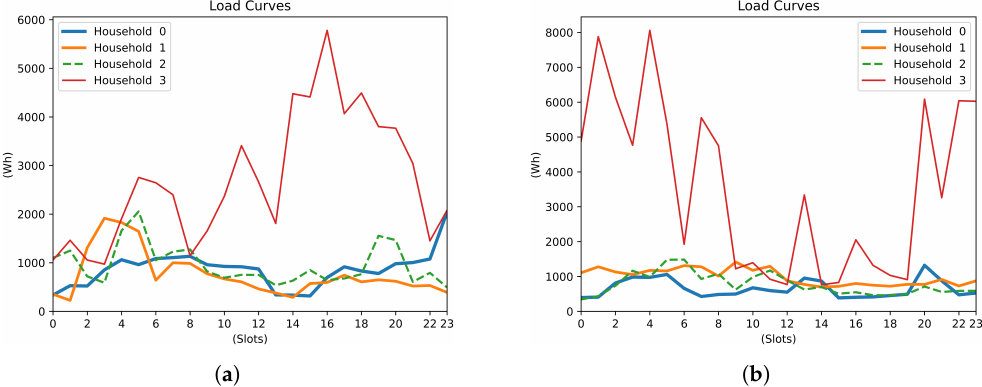
Figure 5. Load curves for two days in different seasons. ( a ) Households load curves in winter (1 January). ( b ) Households load curves in summer (29 July). Table 8. Duration and energy demand of schedulable